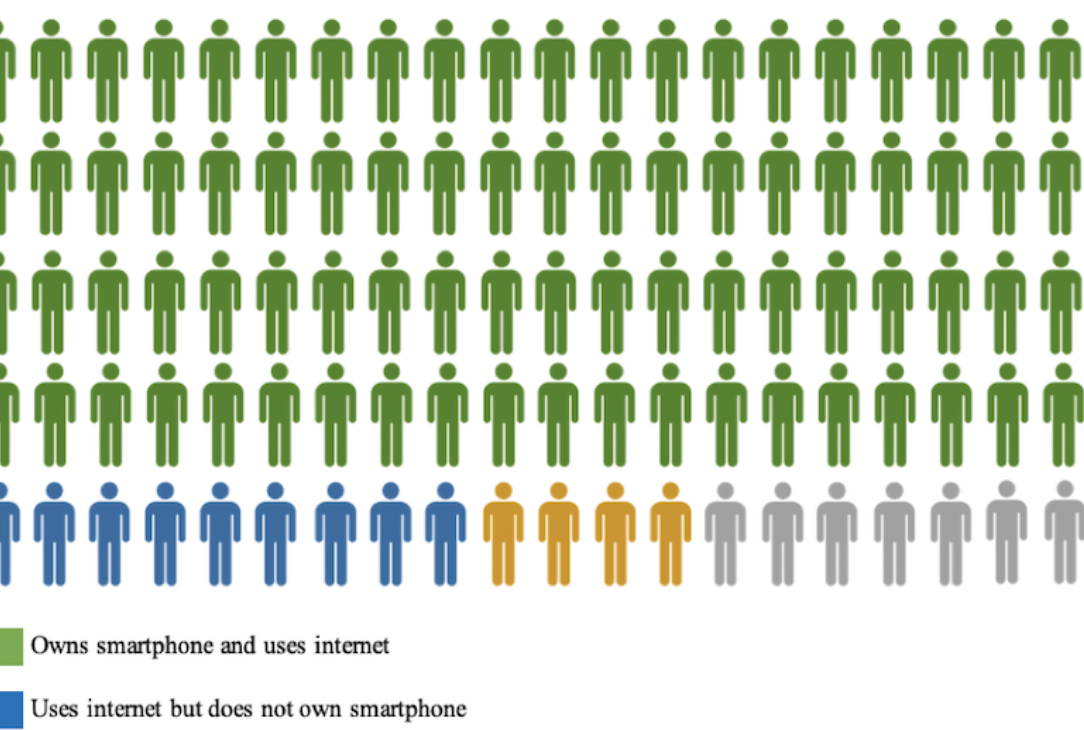
Figure 1. Prevalence of smartphone ownership and internet use among study